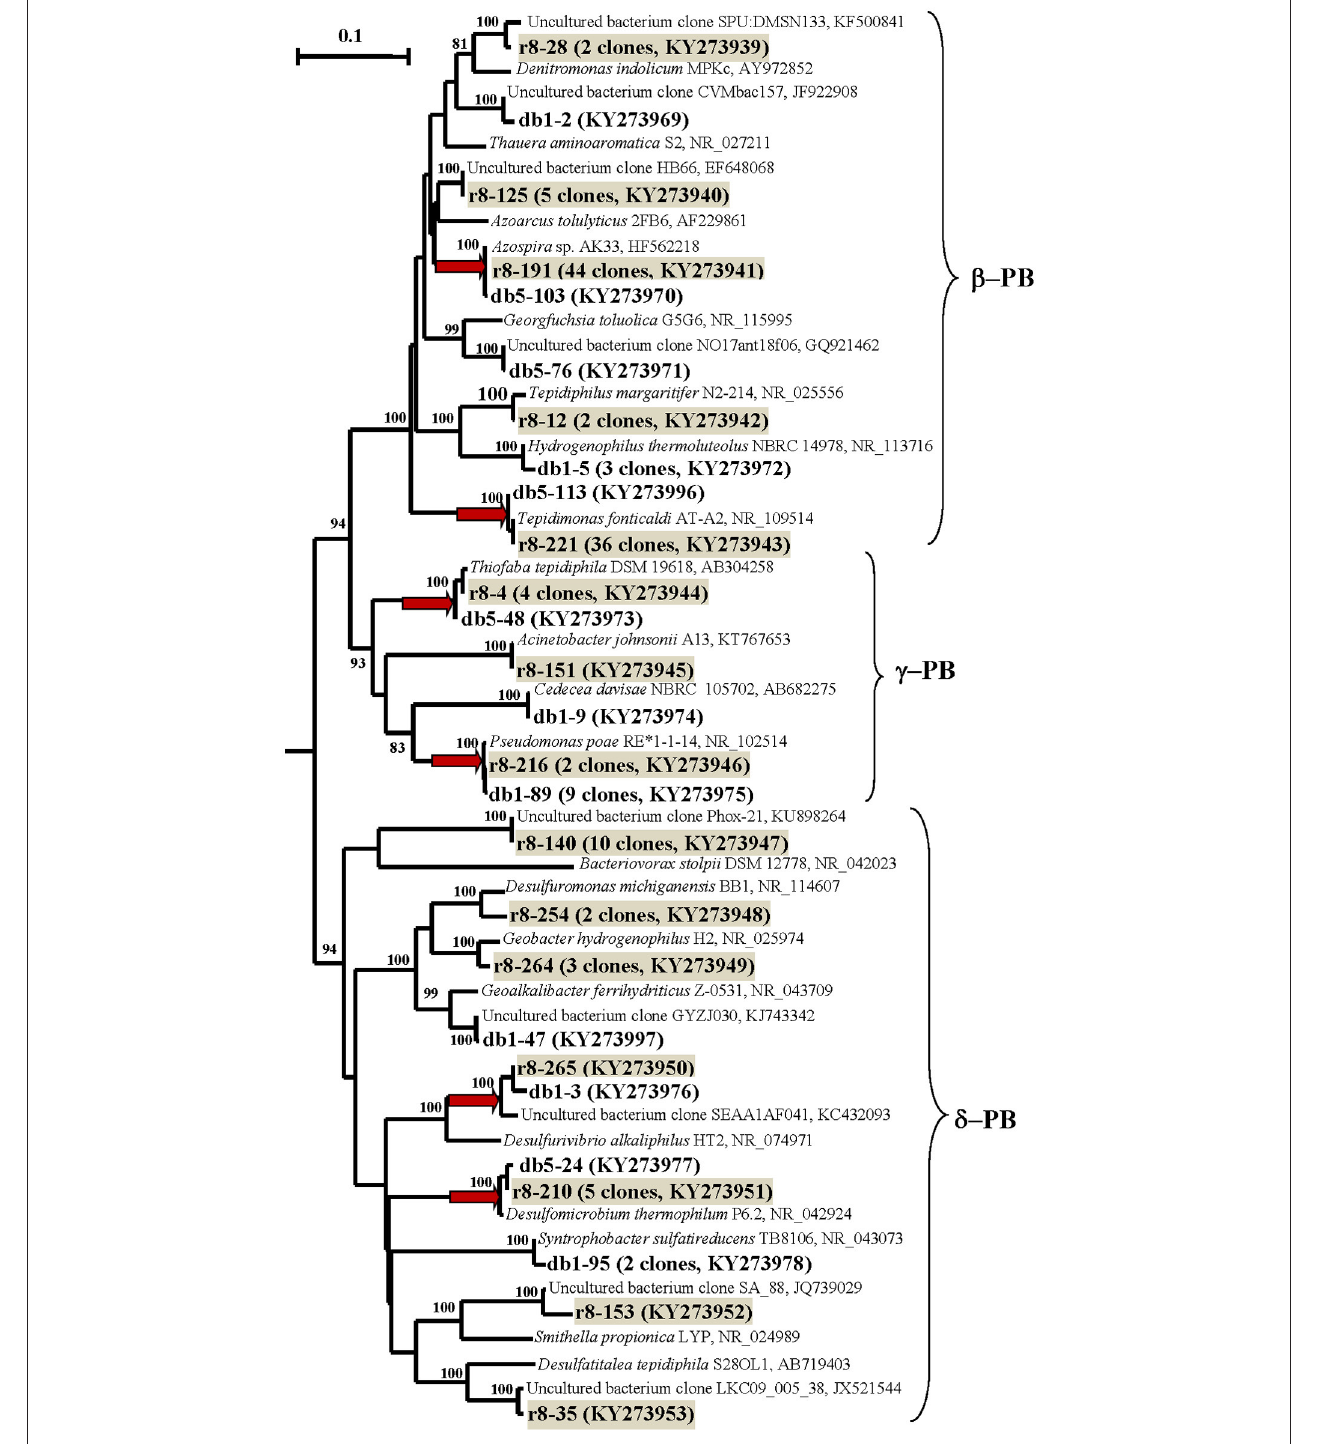
FIGURE 4 | Phylogenetic neighbor-joining tree constructed on the basis of analysis of the 16S rRNA gene and cDNA of 16S rRNA sequences of Proteobacteria revealed in the DNA- and RNA-derived clone libraries of formation water from near-bottom zone of injection well 1098-8 m 3 sampled in December 2006 from the Kongdian bed. The designations are as on Figure 3